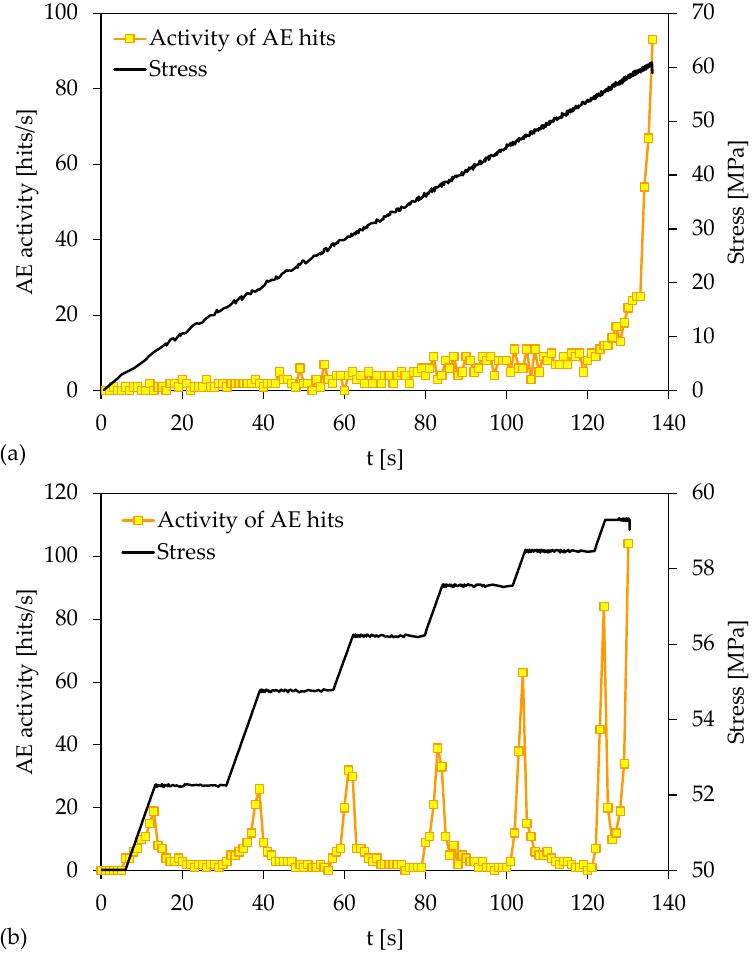
Figure 3. The acoustic activity in terms of hits per second against the applied stress for ( a ) the UC and ( b ) the UCSS loading protocol.